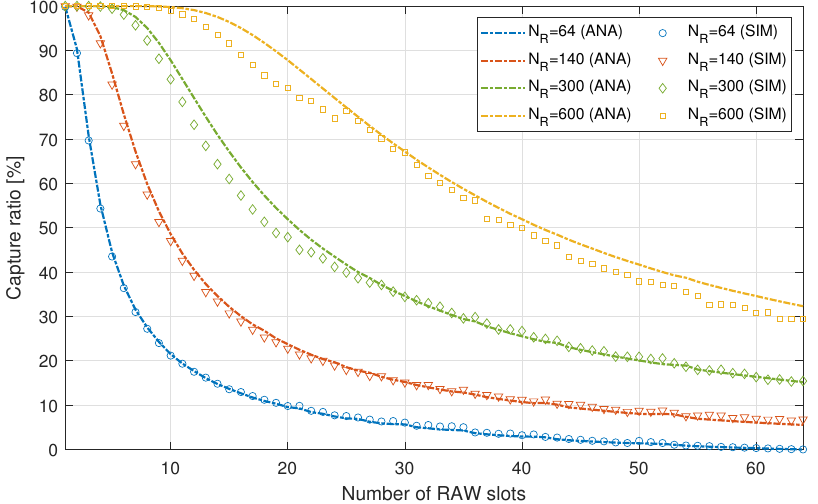
Figure 15. Capture gain in terms of allocated RAW slots for different sets of assigned stations to the